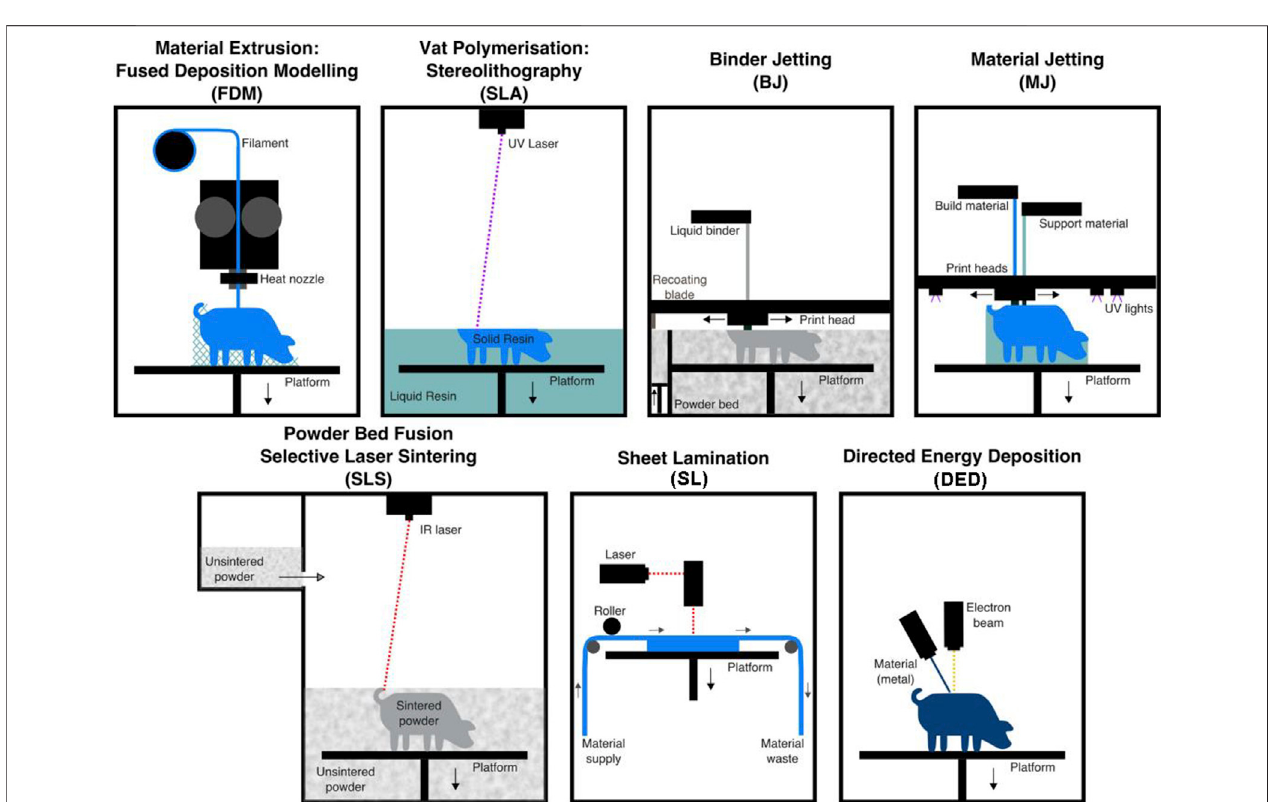
FIGURE 1 | Illustrations of the seven types of 3D printing technologies. Adapted with permission from (Carew and Errickson, 2020).